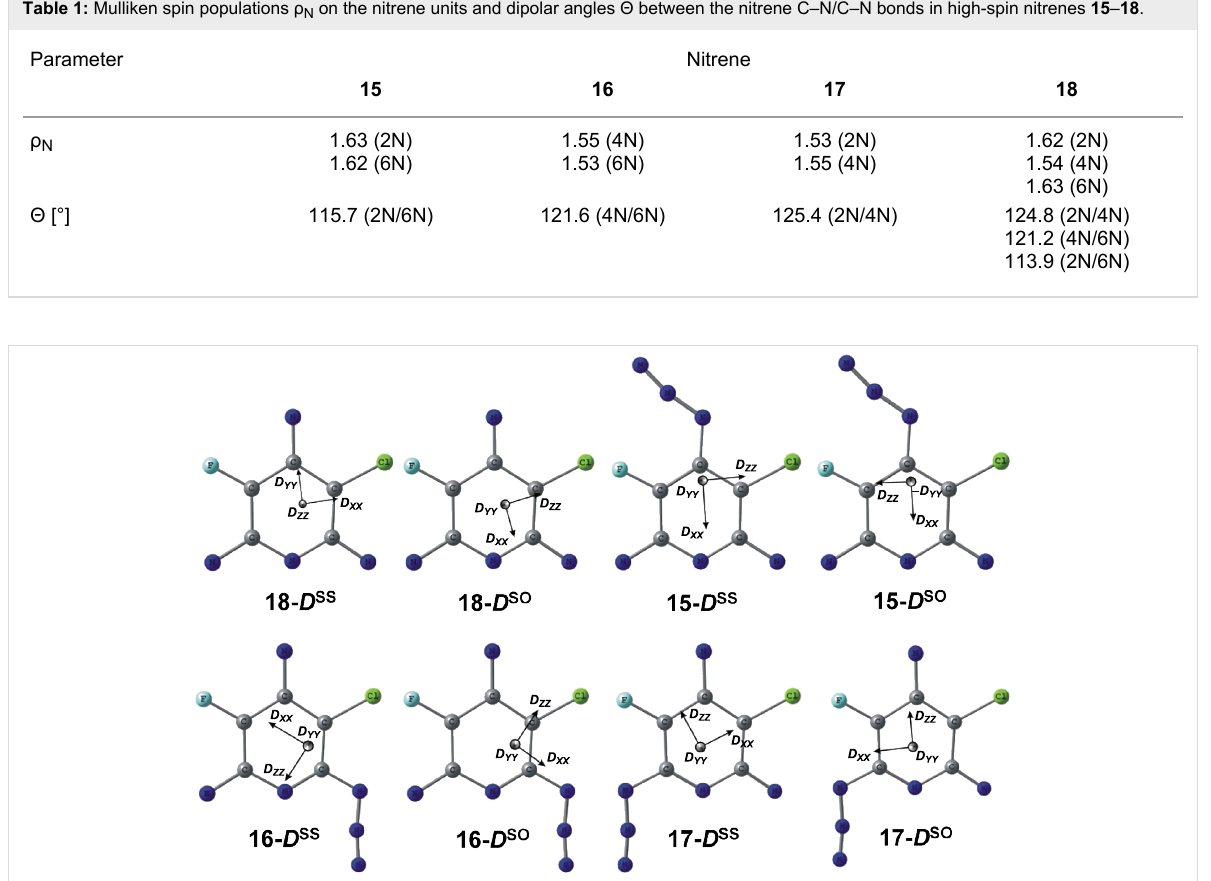
Figure 2: UB3LYP/6-311G*+BLYP/EPRII calculated orientations of the tensors D SS and D SO in nitrenes 15 – 18 . The tensors D SS and D Tot have the same